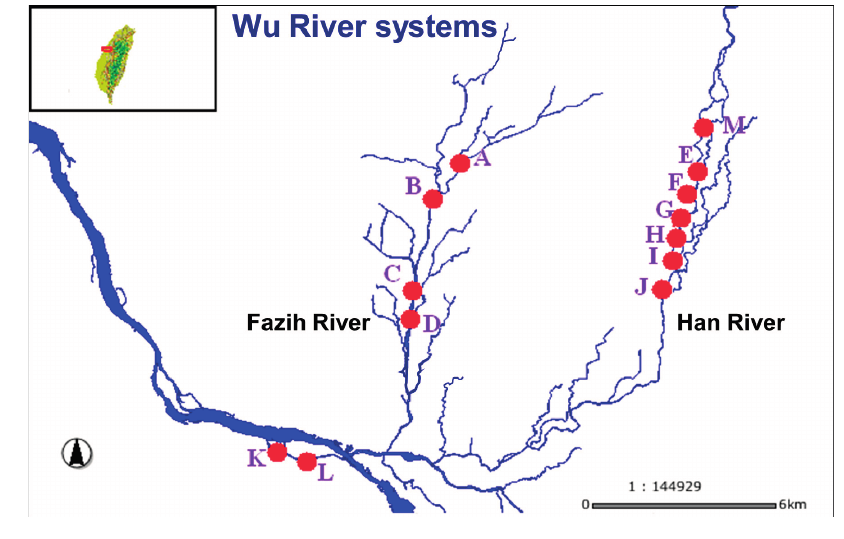
Figure 1. The study area. Red symbols are the locations of water quality sampling stations and referent features in the Wu River